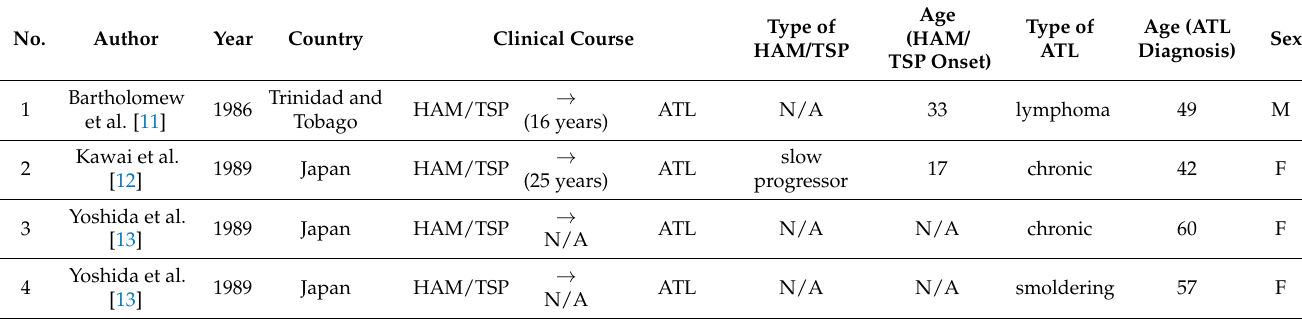
Table 5. Published cases of HAM/TSP associated with